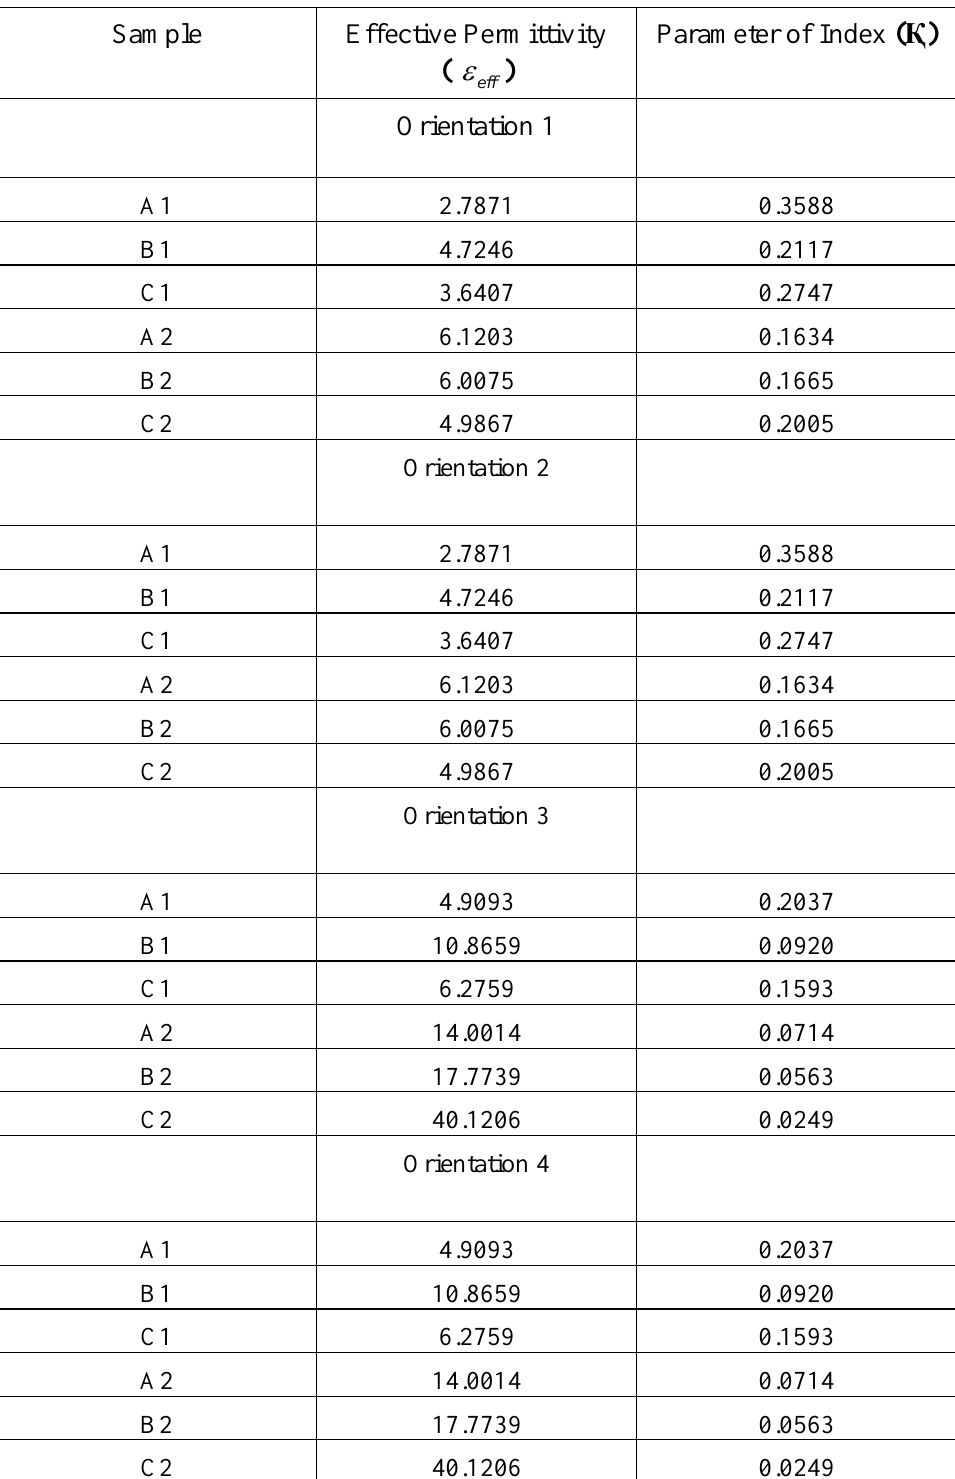
ε and Қ for sensor eff